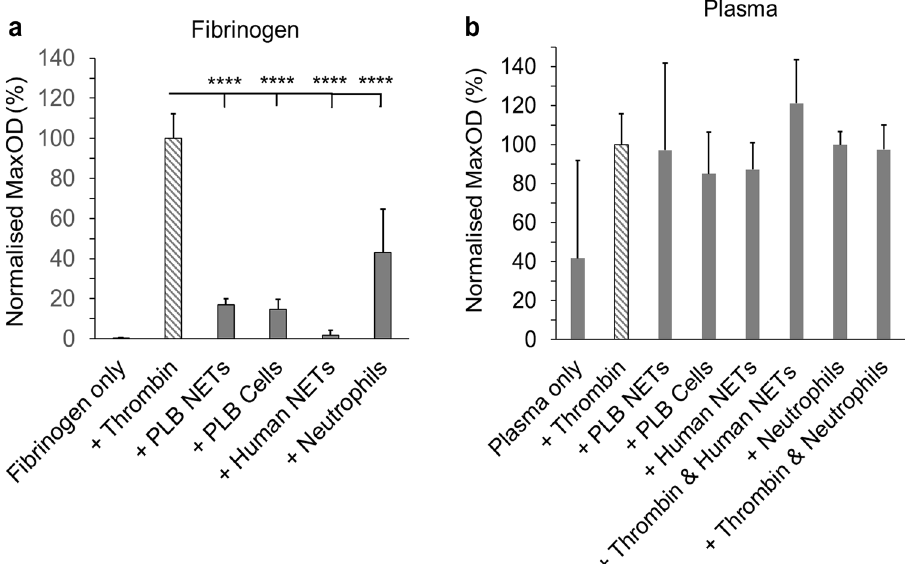
Figure 2. Effects of neutrophils and NETs on coagulation. Turbidity measurements were carried out in ( a ) a purified fibrinogen system or in ( b ) NPP. Differentiated PLB-985 cells or human neutrophils (200,000 cells/100 µl) or NETs (generated from 200,000 cells/100 µl) were added to purified fibrinogen or plasma. Normalized percentage of MaxOD (compared to thrombin only controls) was quantified. Other concentrations: thrombin (0.1 U/ml), fibrinogen (2 mg/ml), plasma (diluted 1:6) and CaCl 2 (1.5 mM in purified fibrinogen or 3.33 mM in plasma). Error bars represent SD of three technical replicates in triplicates. **** P <